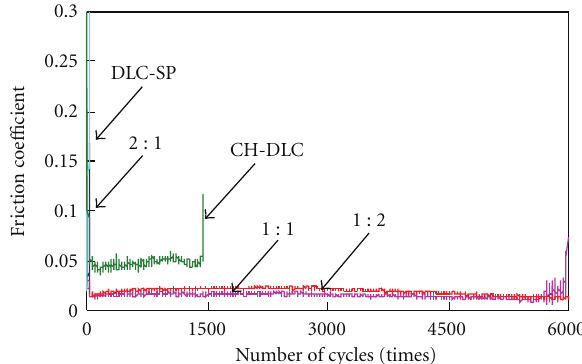
Figure 6: Changes in friction coe ffi cients under high vacuum with bias voltage of 0kV.